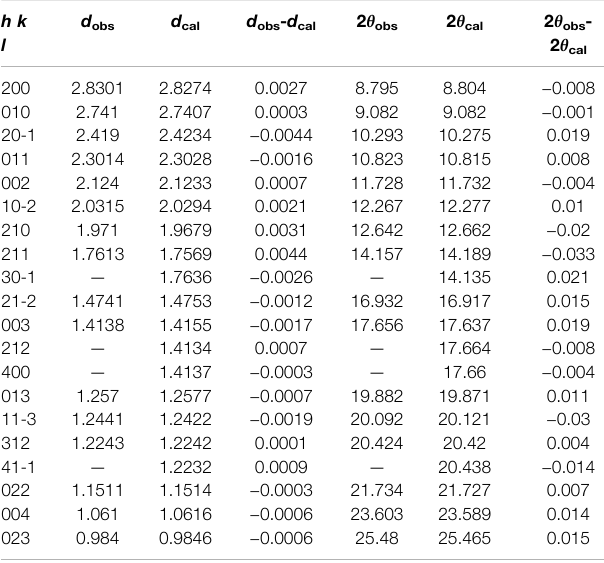
TABLE 1 | Calculated and Observed d spacings of a new monoclinic polymorph Cu 2 O, as well as the normalized intensity I obs for the h k l re fl ections.